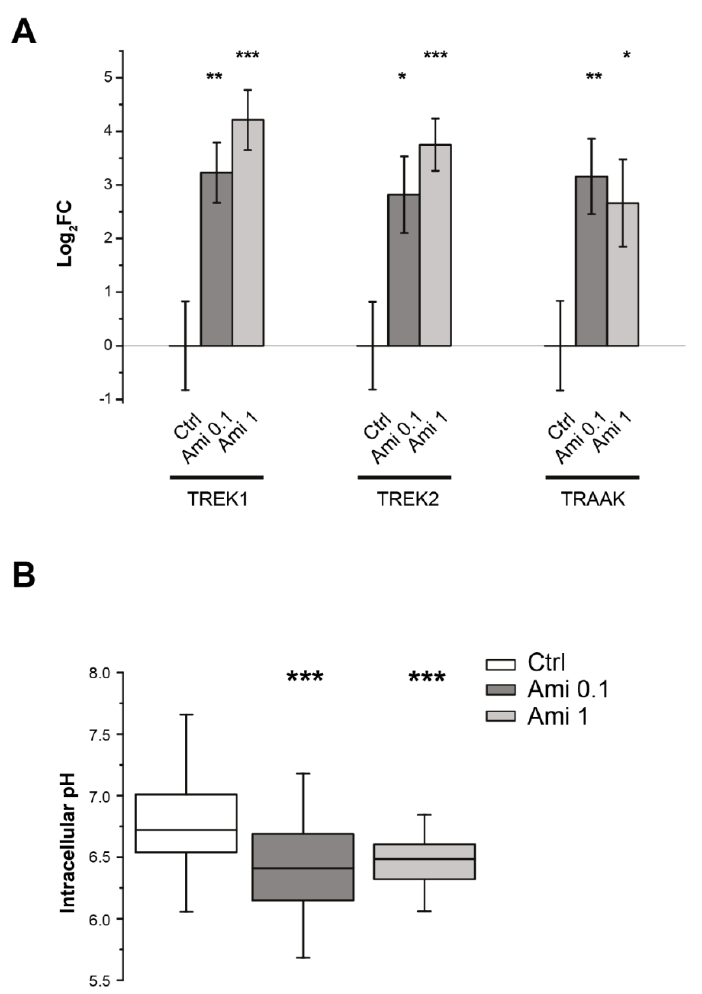
Figure 2. E ff ects of amiloride on DRG cells. ( A ) Each bar represents the mean ± SEM of treated vs. control log 2 FC of gene expression, as measured through RT-qPCR. Data show a significant increase in all the K + two-pore domain (K2P) channels considered in this analysis after 6 h of treatment with two di ff erent concentrations of amiloride (0.1 and 1 µ M). The transcriptional e ff ects of amiloride were assessed by testing the log 2 FC of each experimental condition against its reference control value normalized to zero. In each condition, experiments were performed in n = 4 biological replicates (each in technical triplicate). * p -value < 0.05, ** p -value < 0.01, *** p -value < 0.001; ANOVA and Dunnett’s post hoc test for each channel separately. ( B ) Blockade of Na + / H + exchanger (NHE) with 0.1–1 µ M amiloride significantly decreased intracellular pH in DRG neurons (each box represents 100 to 150 cells from n = 4 independent experiments; *** p -value < 0.001; ANOVA and Dunnett’s post hoc test).